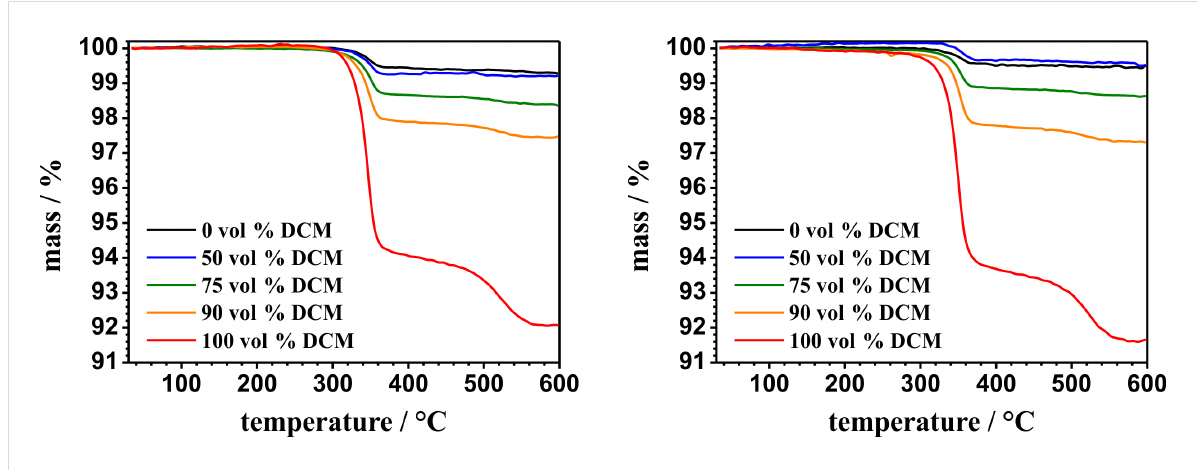
Figure 10: Thermogravimetric measurements from differently functionalized polyphenylalanine ALOX-membranes after the grafting process (left diagram) and after CHCl 3 /DCA treatment (right diagram).